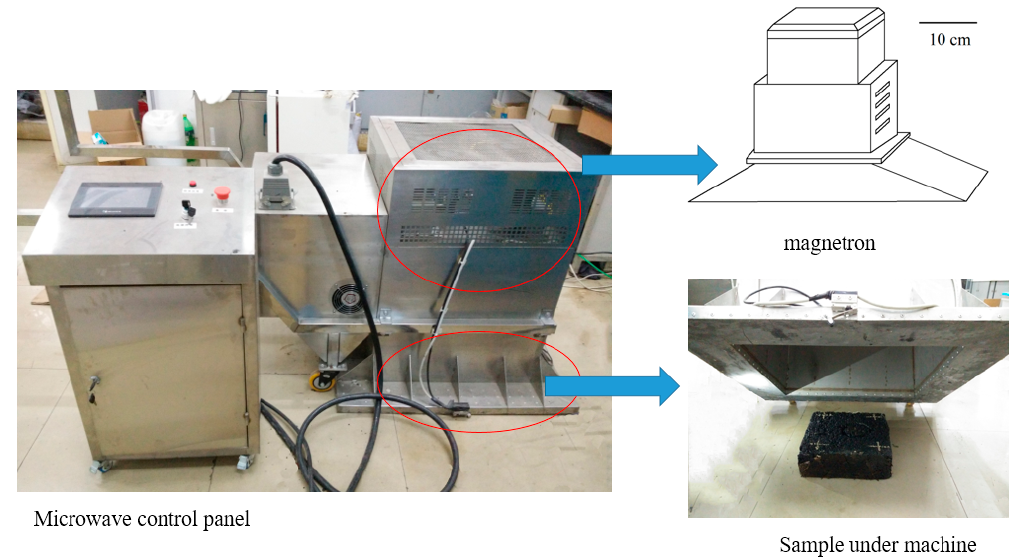
Figure 2. Improved microwave heating machine for slabs.